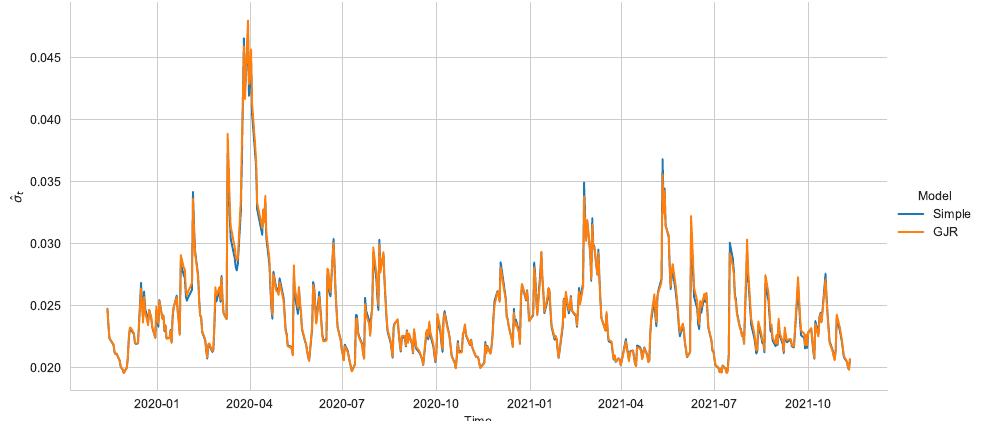
Figure 1. Variance process as estimated from two specifications: the GJR-GARCH with skewed t innovations and the simple GARCH model with normally distributed errors. Despite all diagnostics pointing to the second model, the estimated variance processes are